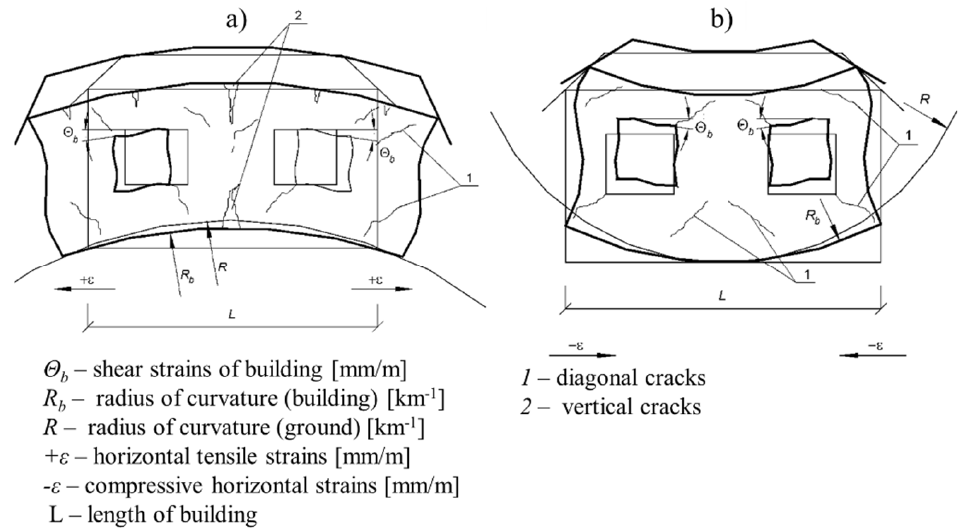
Figure 4. Diagram of damages in buildings located on a: ( a ) convex edge of the mining basin; ( b ) concave edge of the mining basin [30]. Reproduced with permission from [30]; published by Wydawnictwo ITB, 2021.